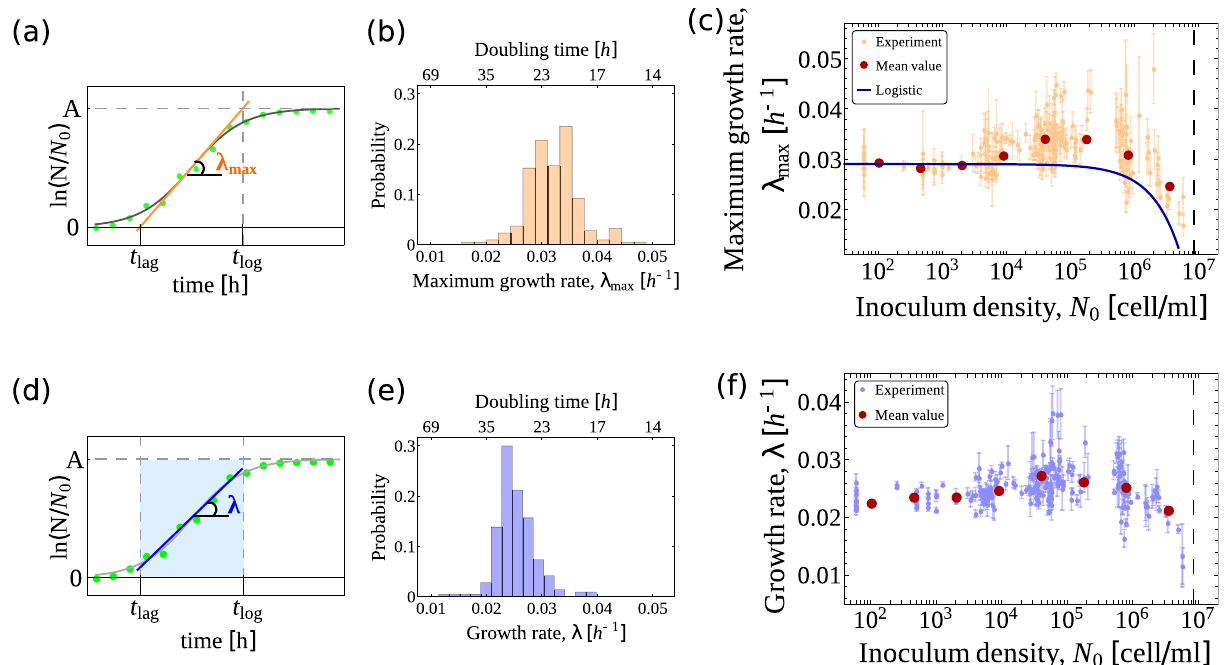
Figure 3. ( a ) Representative growth curve. The fitting parameters are t lag , A and (cid:31) max . The maximum growth rate (cid:31) max corresponds to the slope of the tangent to the inflection point (orange line) of the fitting curve (gray curve). The intersection of such a tangent with the time-axis gives the lag time t lag , while its intersection with the line ln ( N / N 0 ) = A yields the time of exit from the exponential phase, t log . ( b ) Empirical distribution of the maximum growth rate. ( c ) Maximum growth rate (cid:31) max as a function of the inoculum density N 0 . Orange dots represent parameter estimates from individual experiments with their standard errors, while red dots represent the mean values of (cid:31) max . The dashed vertical line marks the value of the mean carrying capacity. The blue line denotes the behaviour of (cid:31) max vs N 0 expected on the basis of a purely logistic model with k = 8.4 × 10 6 and asymptotic growth rate r = 0.029 (see “Materials and methods”). ( d ) Representative fit of a growth curve using an alternative measure of the growth rate (cid:31) , given by the slope of the linear fit of the data points within the exponential phase of growth (light blue region). ( e ) Empirical distribution of the alternative growth rate defined in panel ( d ). ( f ) Estimated alternative growth rate versus N 0 . Light blue dots represent results from individual experiments with their standard errors, dark red dots represent their mean values. The dashed vertical line marks the value of the mean carrying